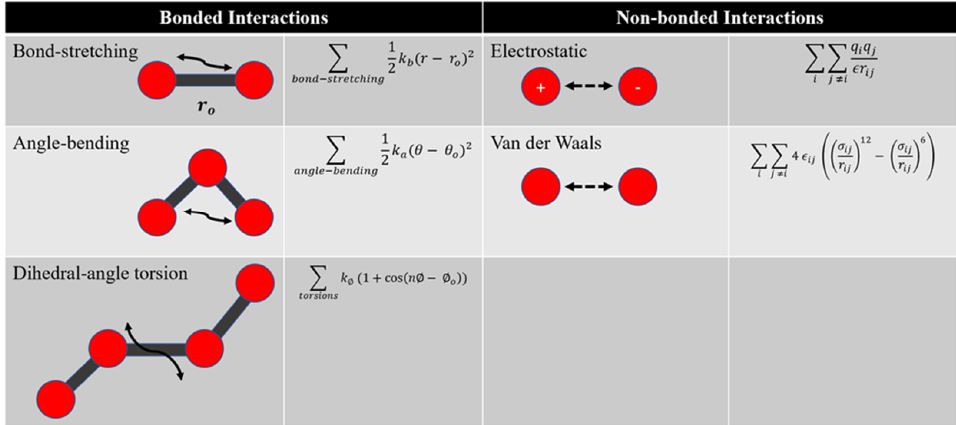
Figure 2. Summary of bonded and non-bonded interactions, considered in Class I force fields AM- BER, CHARMM, GROMOS, and OPLS, and their distinct potential energy